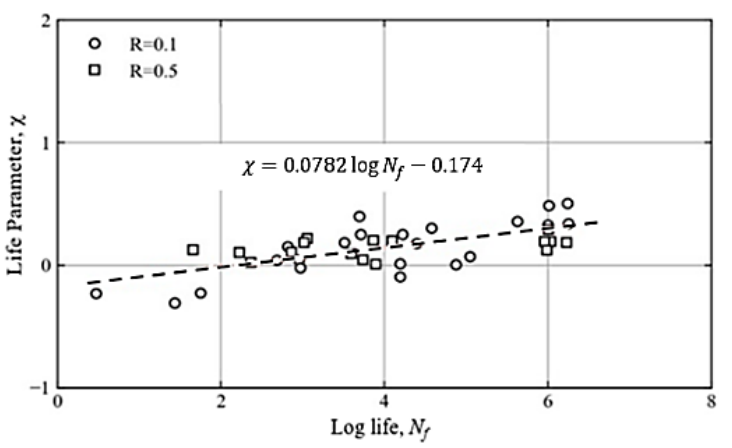
Figure 4. Interface fatigue life model data for CFRP composite laminates for mode I loading. The model was coded in Fortran language and integrated with the FE package [24] through a user-written subroutine (UMAT). The flowchart of the subroutine is shown in Figure 5.